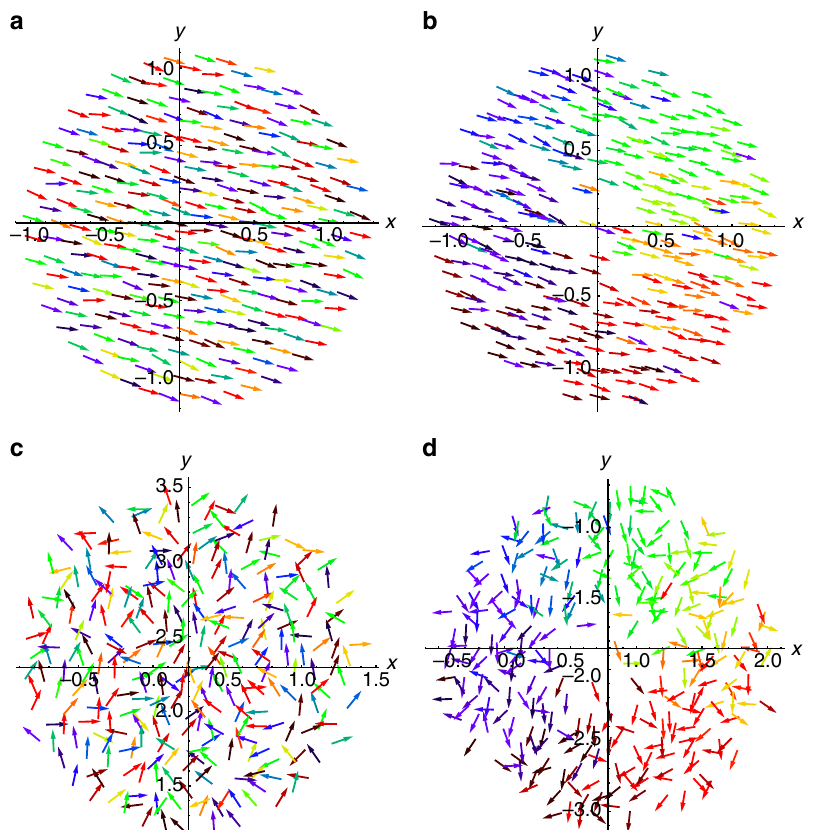
Fig. 10 Scatter plots with alignment. Four states in the ( x , y ) plane where the swarmalators are depicted as colored arrows, whose orientation represents β , and whose color represents the phase θ . Data were collected for N = 300 swarmalators for T = 5000 time units with stepsize d t = 0.01 using Heun ’ s method. In each panel, parameter values were J = δ = 0.5, σ = D θ = D β = 0.01, D x = D y = 0 and v 0 = 0.001. a Aligned active async for ( K , D β ) = ( − 1.0, 0.01). b Aligned noisy phase wave for ( K , D β ) = ( − 0.1, 0.01). c Unaligned active async for ( K , D β ) = ( − 1.0, 1.0). d Unaligned noisy phase wave for ( K , D β ) = ( − 0.1,